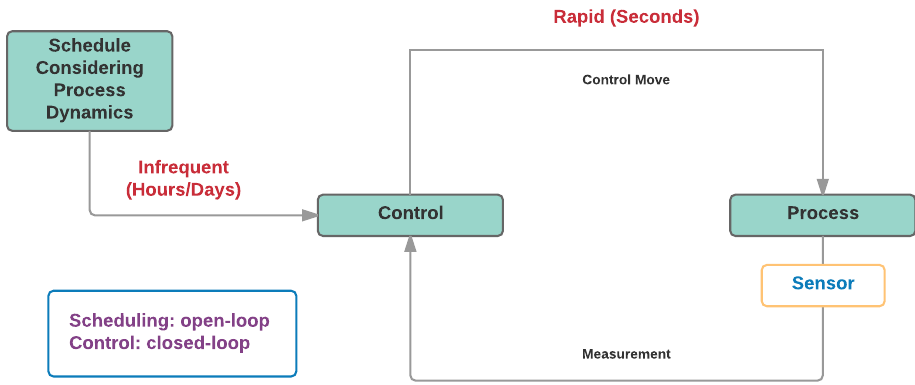
Figure 3. Phase 3: Open-loop scheduling determined once per day with consideration of process dynamics and control structure in the form of grade transition information. Closed-loop control implemented to follow the schedule.